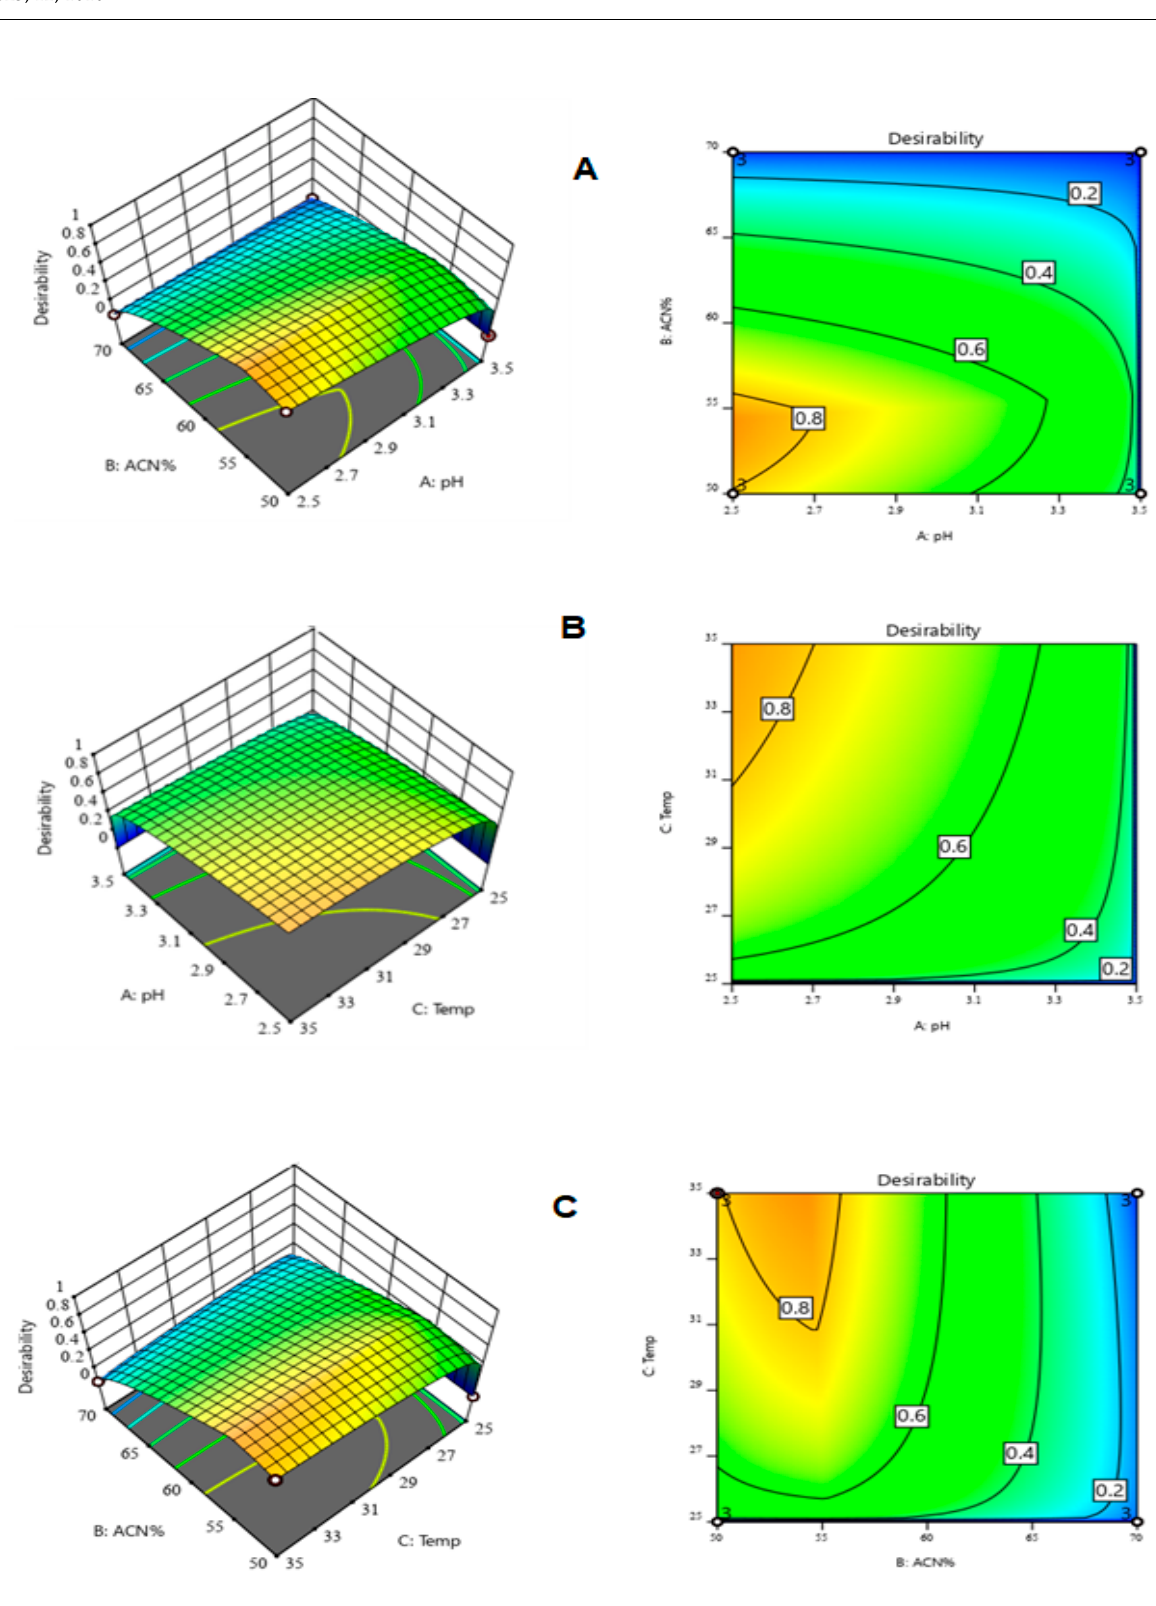
Figure 3. A 3D plot of Derringer’s desirability function in correlation with variable acetonitrile and pH ( A ), pH and temperature of the separation column ( B ), and temperature and acetonitrile composition % ( C